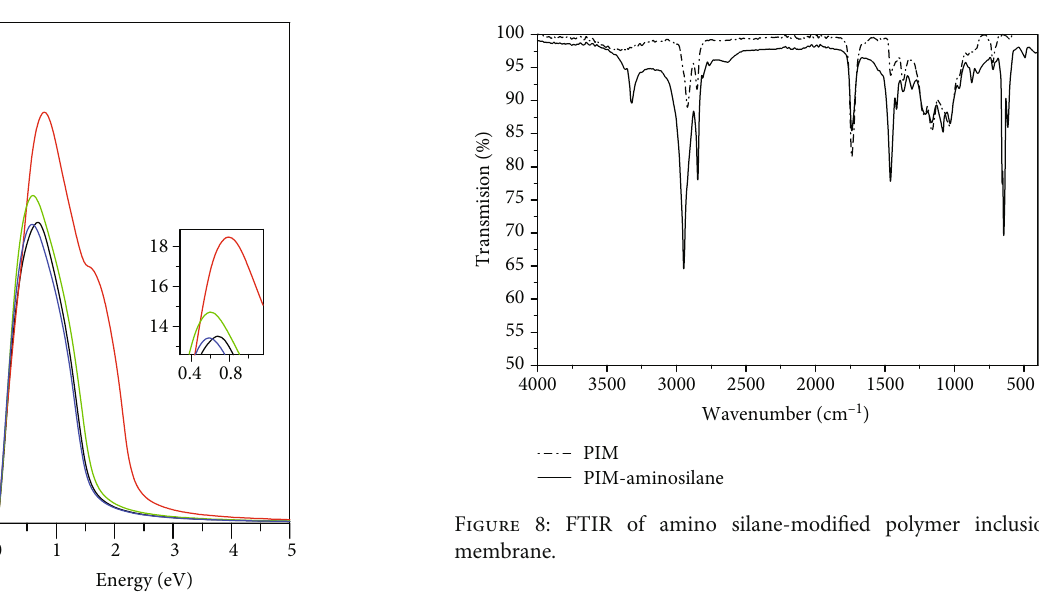
ð ω Þ parts of the dielectric function. 2